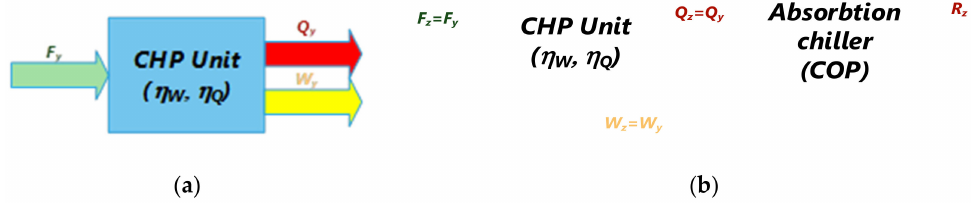
( a ) Cogeneration system (CHP) scheme; ( b ) trigeneration system (summertime configuration-CCHP) scheme. F y / F z —fuel thermal content for CHP/CCHP processes kWht; Q y / Q z —heat from CHP/CCHP processes kWht; R z —cooling from CCHP process (kWht); W y / W z —electricity from CHP/CCHP processes (kWhc); η W / η Q -electrical/thermal energy